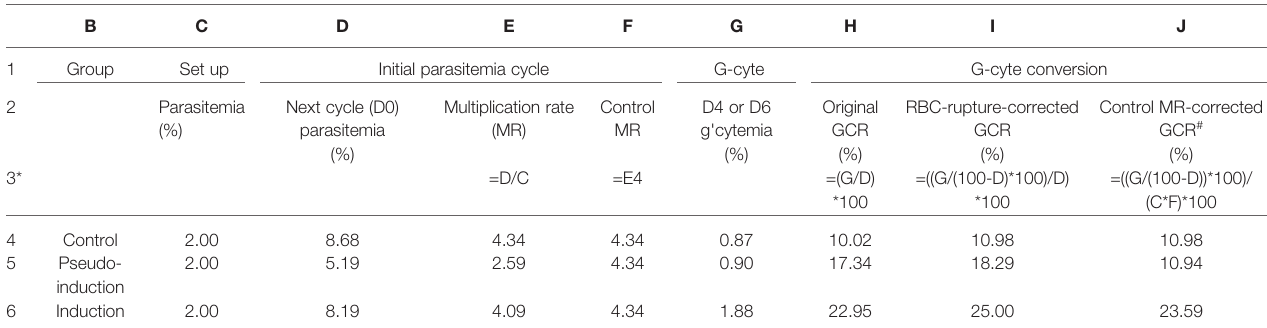
TABLE 1 | Gametocyte conversion calculation